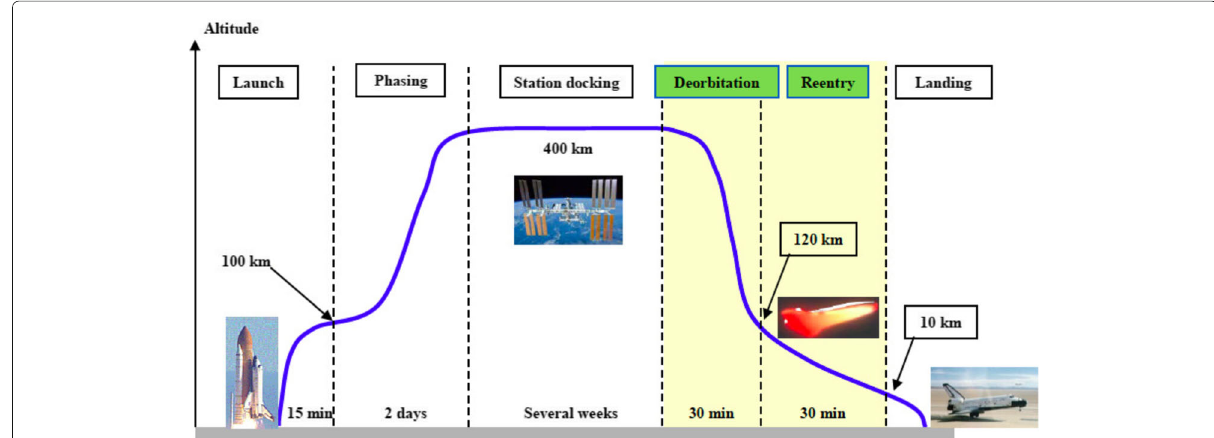
Fig. 2 ISS servicing and shuttle